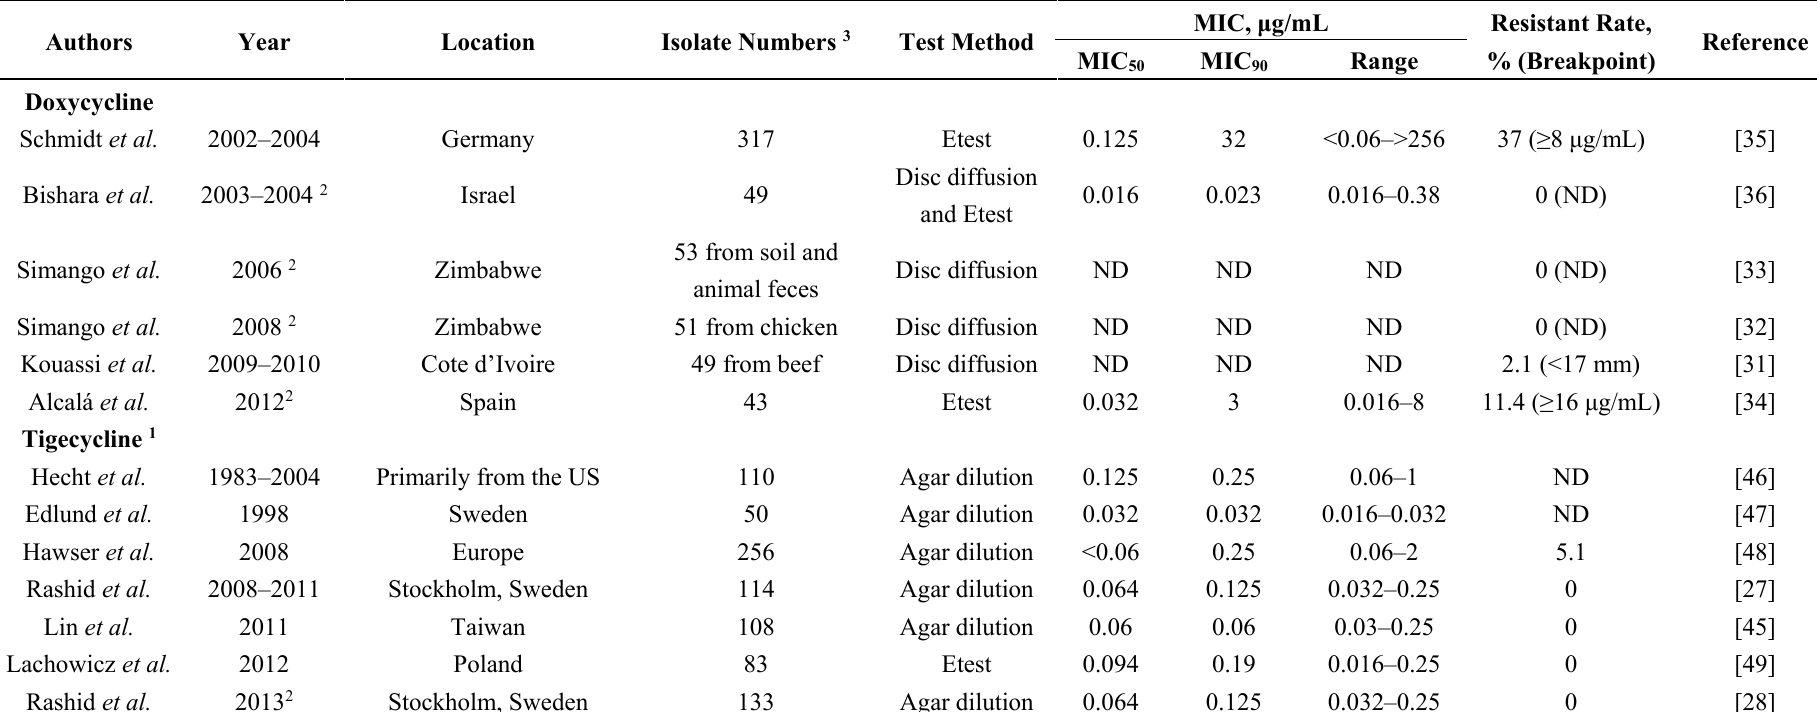
Table 1. In vitro susceptibility of doxycycline and tigecycline against Clostridium difficile